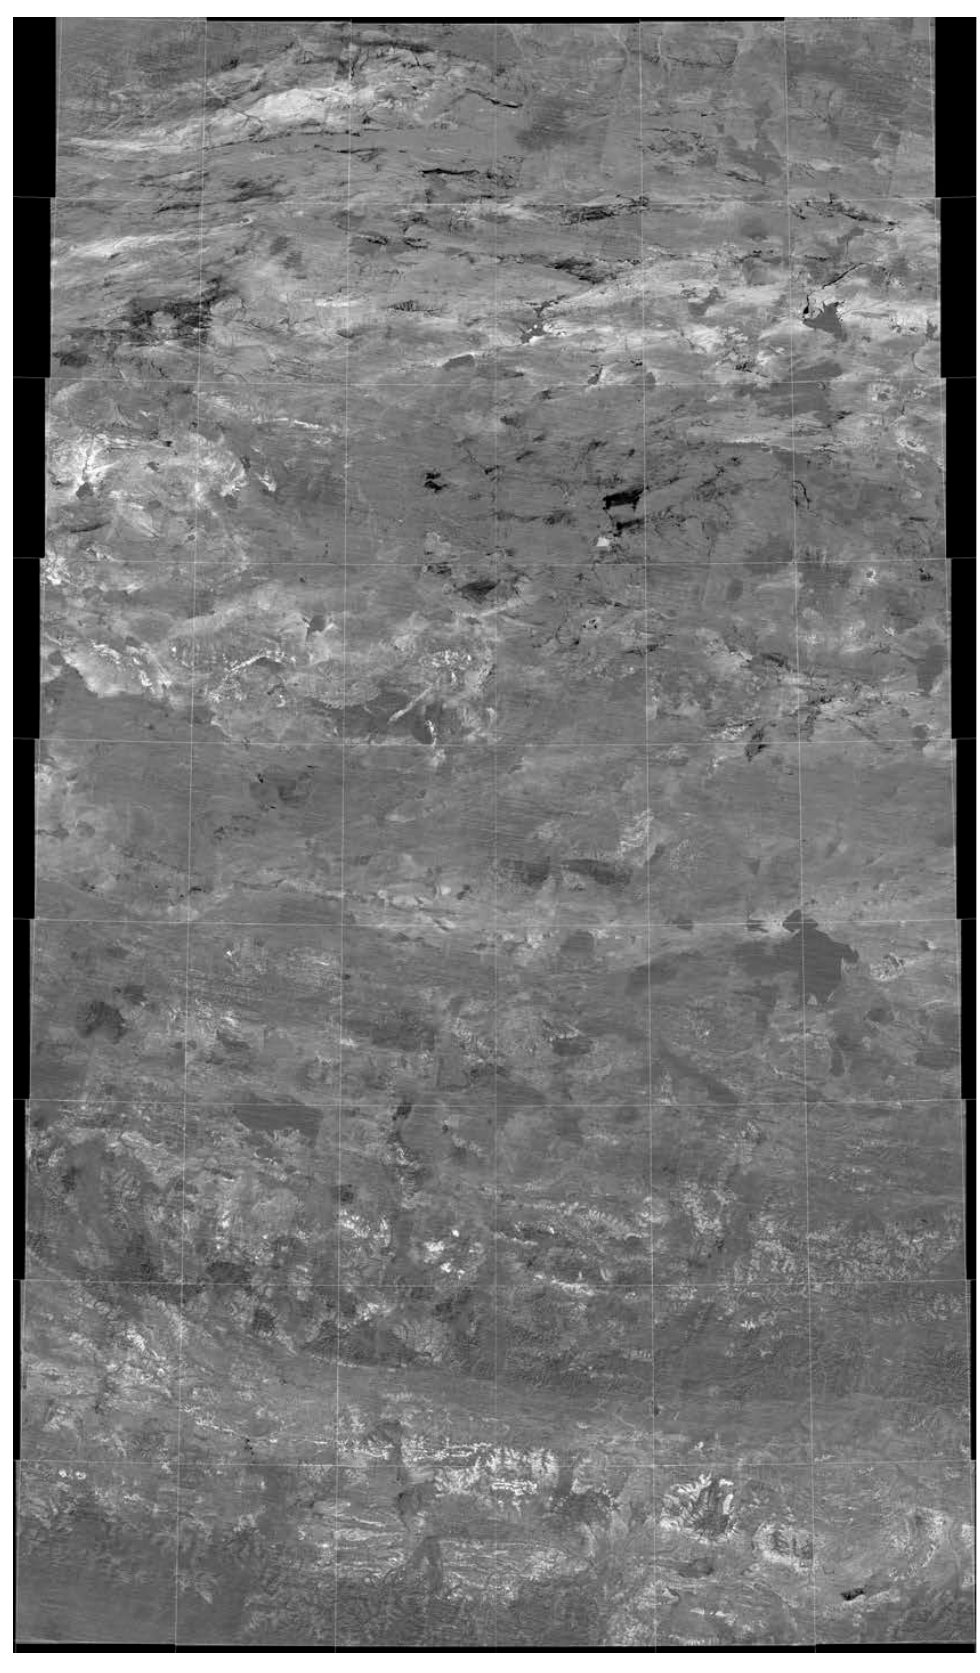
Figure A3. High resolution version of Figure 5a without annotated information.